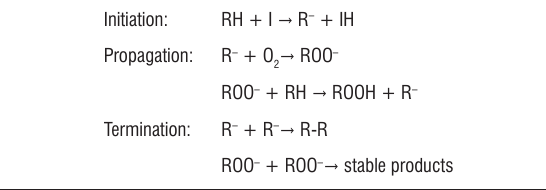
Figure 1: Principle of the Rancimat instrument. 11